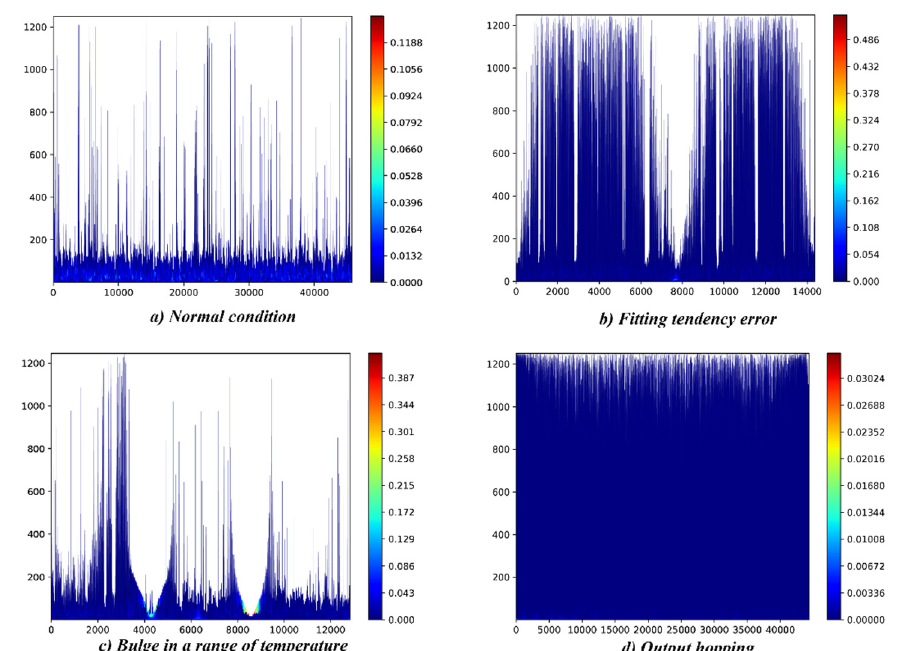
Figure 12. Hilbert spectrum based on EMD results which are shown in Figure 11. ( a ) Hilbert spectrum in case of normal condition; ( b ) Hilbert spectrum in case of fitting error fault occurs; ( c ) Hilbert spectrum in case of bulge in a range of temperature fault occurs; ( d ) Hilbert spectrum in case of output hopping error fault occurs.